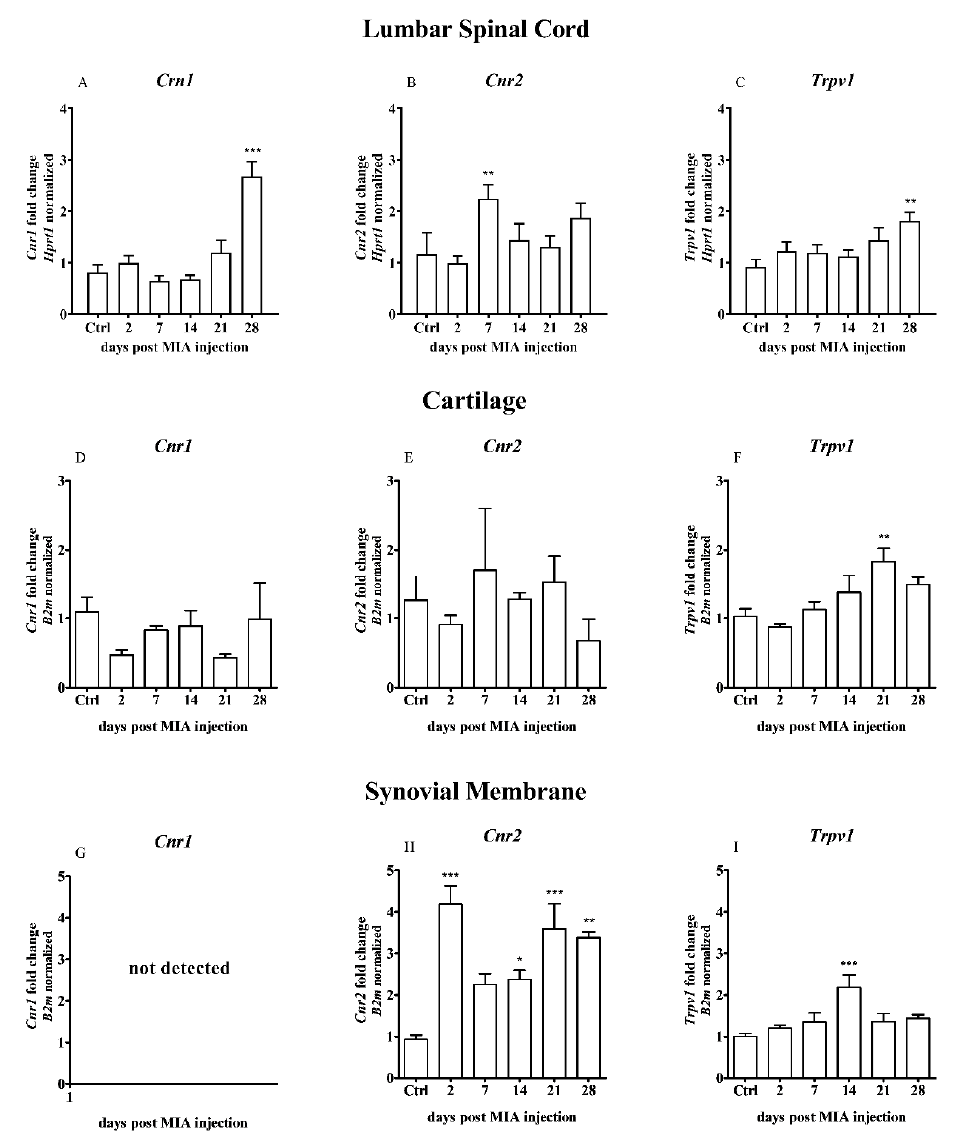
Figure 3. Transcript levels of the cannabinoid receptor type 1 and 2 ( Cnr1 and Cnr2 ) and transient receptor potential cation channel subfamily V member 1 ( Trpv1 ) genes in the ( A – C ) lumbar L4-L6 spinal cord segments, ( D – F ) cartilage and ( G – I ) synovial membrane of rats after 3 mg MIA injection during OA development. Samples were collected 2, 7, 14, 21 and 28 days after MIA injection; the